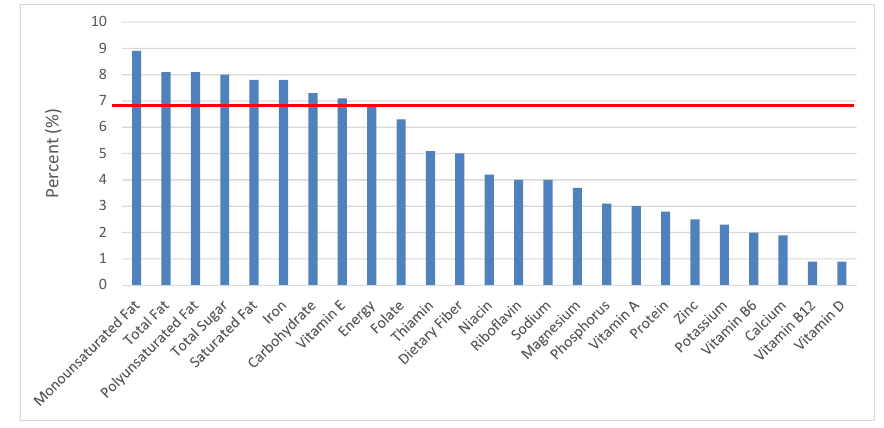
Figure 26. Sweet bakery products as sources of energy and nutrients for children and adolescents 2–18 years old ( N = 6109, daily intake data): DFE = Dietary Folate Equivalents; solid red line represents percentage of energy (kcal) provided in the diet relative to nutrients—nutrients above the red line show the grain food’s contribution to nutrient density.